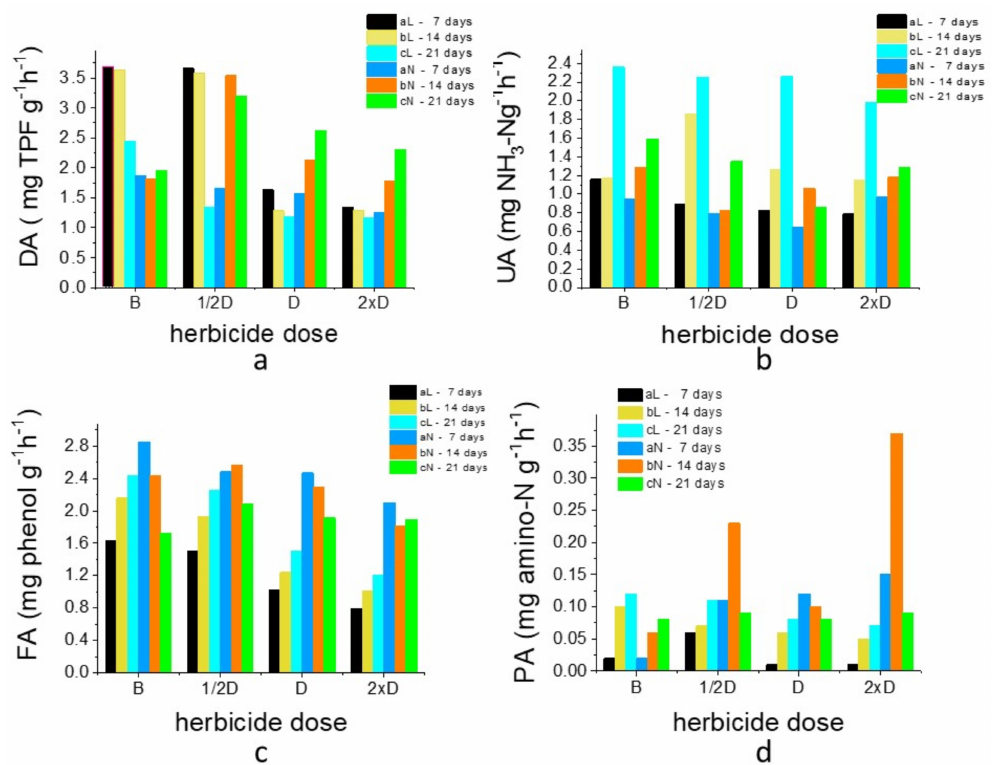
Figure 1. Enzymatic activities in soil samples maintained in both laboratory (aL, bL, cL) and field (aN, bN, cN) conditions and treated with various doses of oxyfluorfen (B—samples untreated with oxyfluorfen, 1 D—normal dose, 2 × D—double dose) in relation to the exposure periods: DA ( a ); UA ( b ); FA ( c ); PA ( d